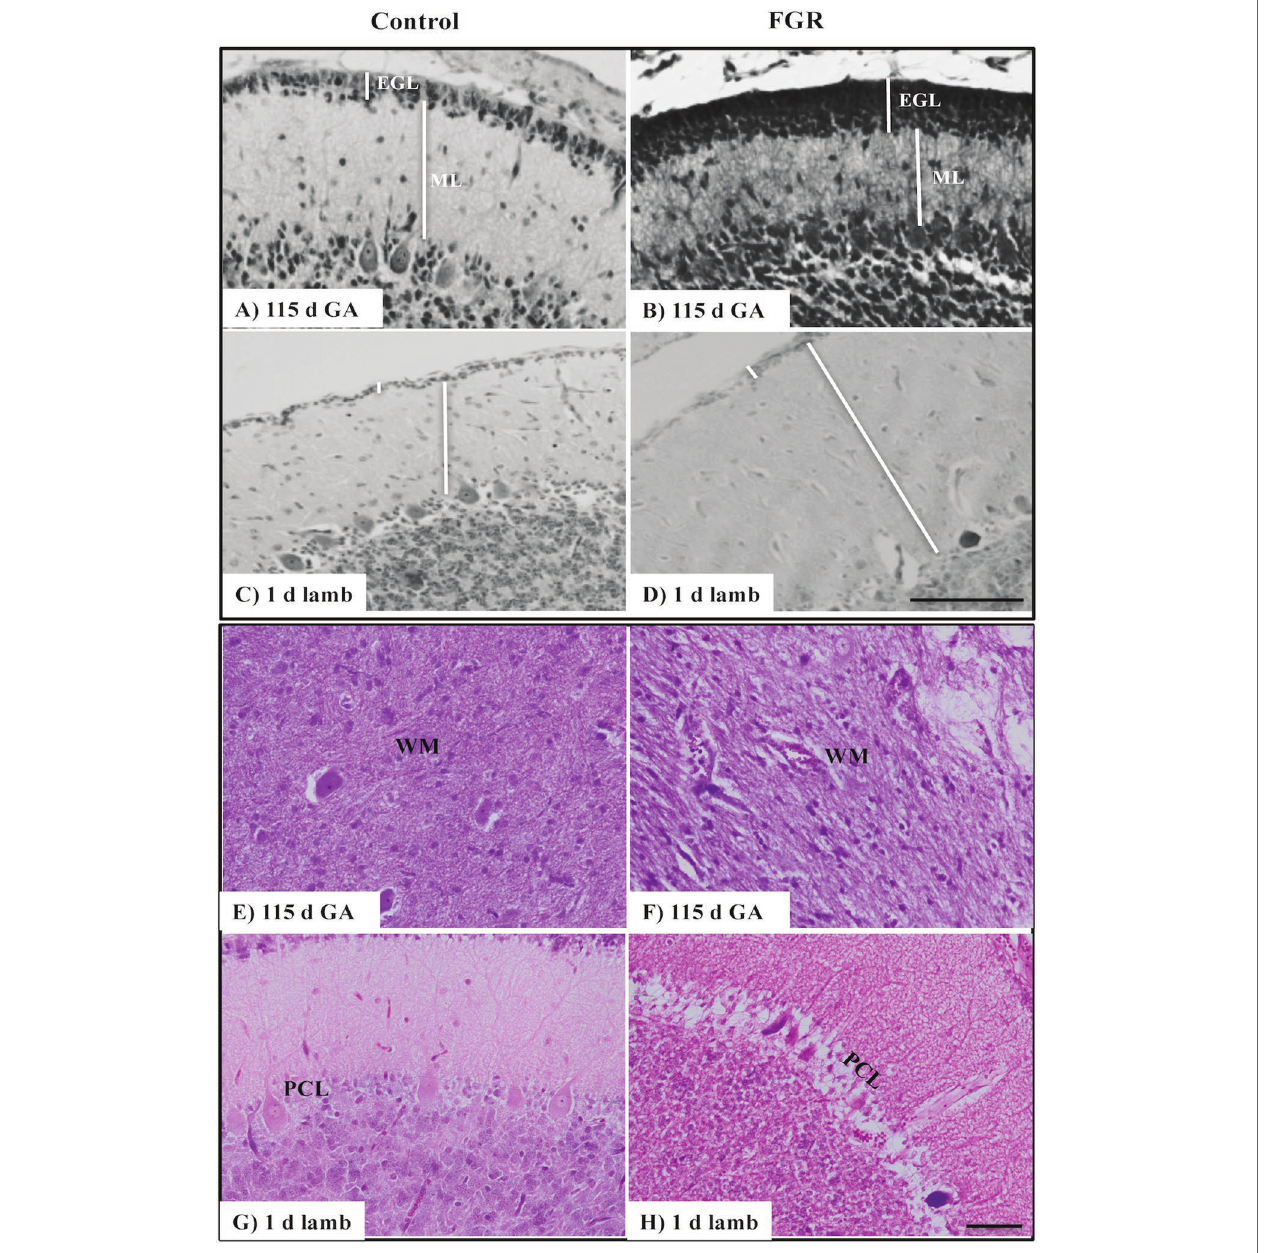
FIGURE 1 | Representative micrographs of cresyl violet and acid fuchsin staining in a 115 d GA fetus and 1-day-old lamb of control (A,C,E,G) and FGR (B,D,F,H) brain. (A–D) show measurements of EGL and ML on each image. Within FGR brains, note the presence of vacuolization in parenchymal WM tissue (F) and Purkinje neurons with abnormally shaped, darkly stained nuclei (H) . EGL, external granular layer; ML, molecular layer; PCL, Purkinje cell layer; WM, white matter. Scale bar for (A–D) in (D) = 100 μm and (E–H) in (H) = 50